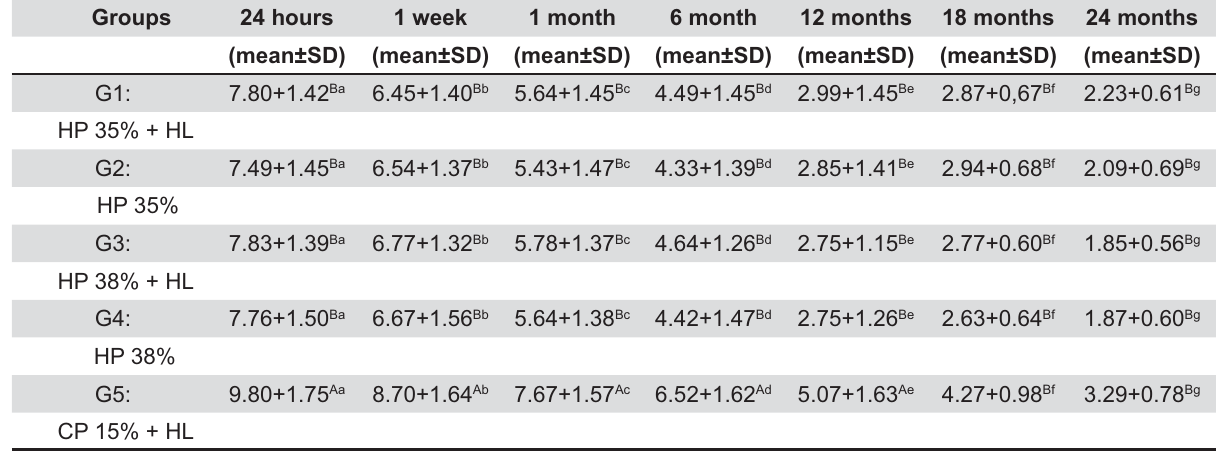
* Lower case letters: analysis between columns in the same line * Capital letters: analysis between lines in the same column (cid:10)K&(cid:5)(cid:23)(cid:21)(cid:30)(cid:29)(cid:21)"(cid:5)(cid:26)(cid:21)%(cid:23)(cid:22) Table 2- Description of the sensitivity results based on the bleaching gel used